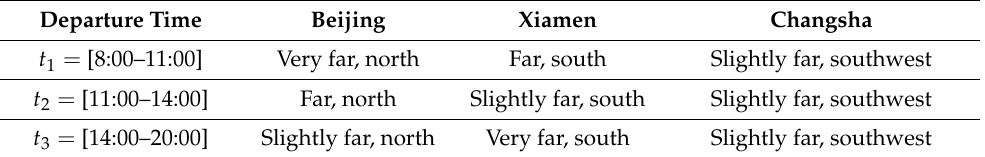
Table 9. Linguistic assessments.